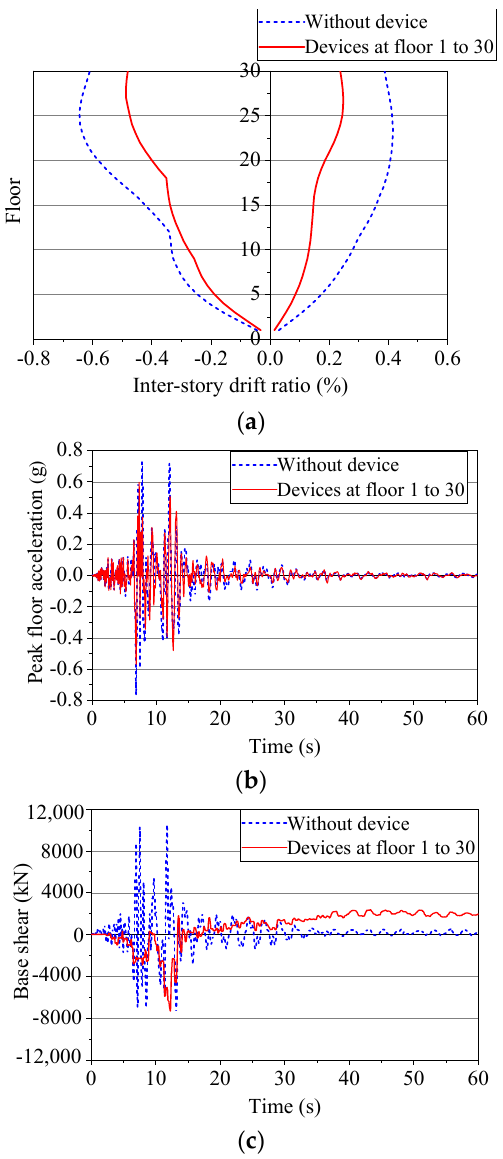
Figure 24. Devices at floors 1 to 30: ( a ) Inter-story drift; ( b ) Floor acceleration at 30th floor; ( c ) Base shear.